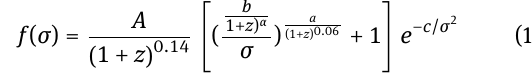
MF, and the diamonds with error-bars represent the MF obtained in the Bolshoi simulation by K11. The z depen- dence in the MF of this paper, comes just from δ c ( z ). At z = 0, rightmost curves, the ST1 MF deviates from the sim- ulation data in less than 10% in the mass range M vir ≃ 5 × 10 9 − 5 × 10 14 h −1 M ⊙ . Going to higher redshifts ST1 overpredicts the simulation results, and the overpredic- tion increases with increasing redshift. At z = 6, and for masses M vir ≃ 1 − 10 × 10 11 h −1 M ⊙ , ST1 predicts 1.5 more halos than simulations, and the situation is much worse at z = 10 since the ST1 MF predicts 10 times more haloes than simulations. Our mass function (solid line), is in good agreement with the simulations with maximum deviations of ≃ 3% calculated by average on each curve from the cen- tral values, intersecting all the